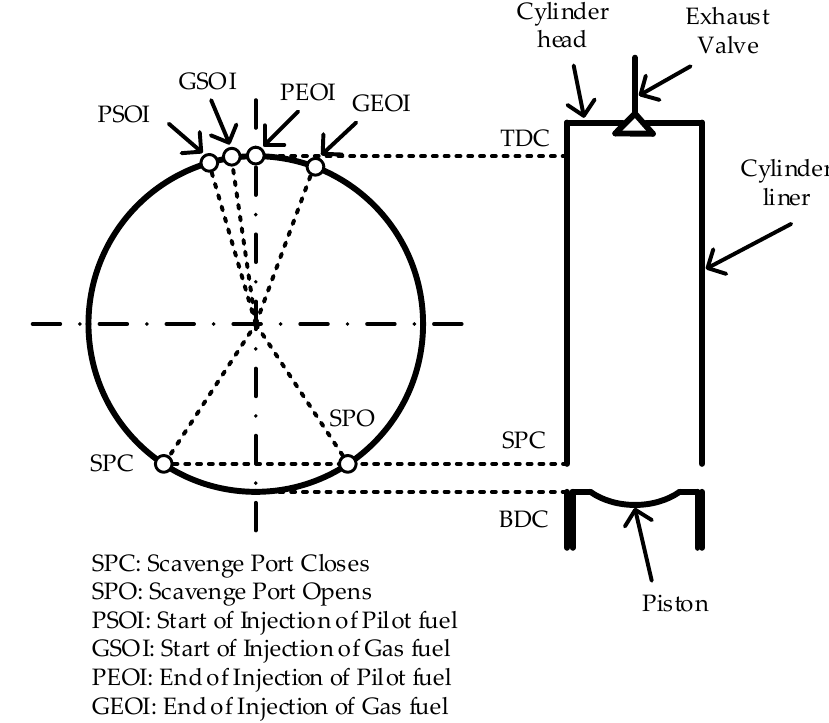
Figure 4. Schematic of the working process of the engine. Table 6. Boundary and initial conditions for the CFD numerical simulations.